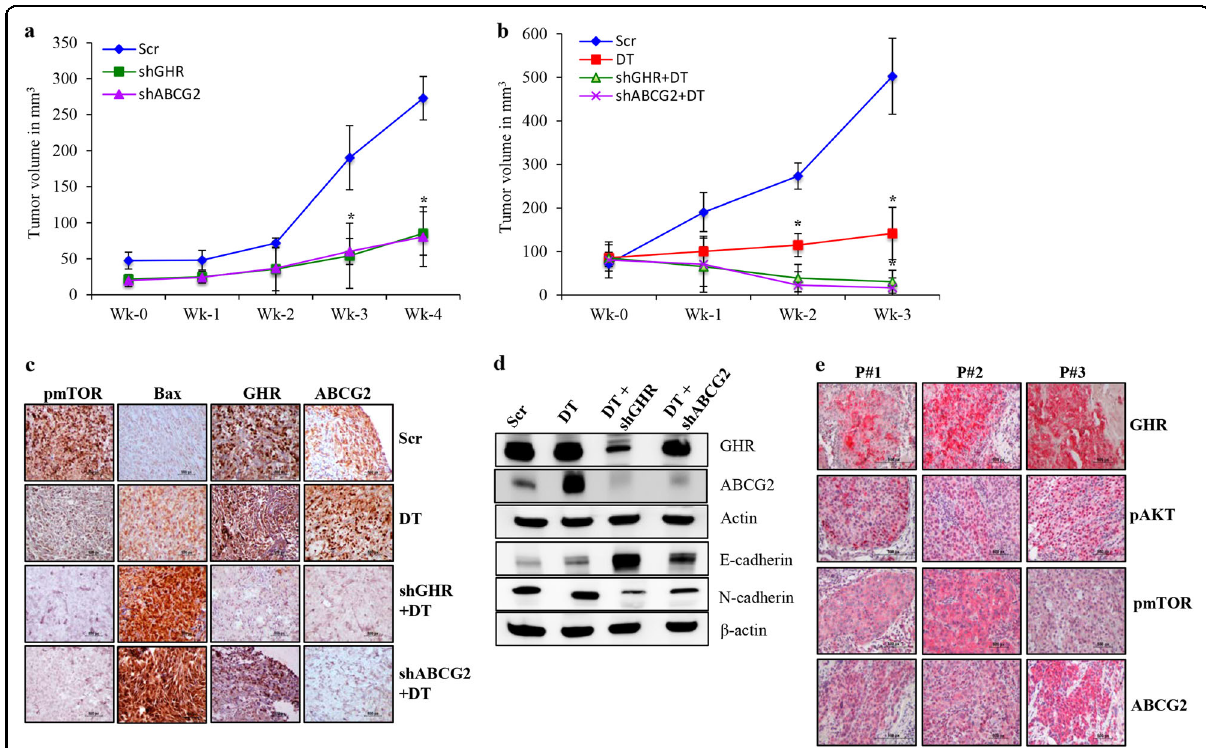
Fig. 6 GHR and ABCG2 knockdown ef fi ciently inhibited the growth of primary breast cancer cells in vivo. a Primary breast cancer cells were stably transfected with scrambled shRNA (Scr & DT groups), GHR shRNA (shGHR group), or ABCG2 shRNA (shABCG2) and ~5 × 10 6 cells resuspended in matrigel were injected into the fl anks of athymic nude mice and the tumor growth was observed. shGHR and shABCG2 tumor growth was very slow compared to control group. b Tumors (~100 mm 3 ) were treated with DT (2.5 mg/kg body weight) and the tumor growth was monitored. GHR and ABCG2 knockdown increased the sensitivity of primary breast cancer cells to DT treatment. DT alone treatment did not reduce the tumor growth, but DT treatment along with GHR or ABCG2 knockdown signi fi cantly reduced the tumor growth ( p < 0.05). c Representative IHC pictures of pmTOR, Bax, GHR, and ABCG2. IHC analysis showed that both shGHR and shABCG2 groups had reduced pmTOR expression and increased Bax expression. d Western blot of xenograft tumors isolated from nude mice showing the expression of GHR and ABCG2. GHR, and ABCG2 levels were reduced in the respective, shRNA transfected groups. e Immunohistochemical staining of GHR, pAKT, pmTOR, and ABCG2 expression in three different primary human breast cancers (P#1 — Patient 1; P#2 — Patient 2; P#3 — Patient 3). Primary breast cancers expressing high levels of GHR also stained strongly for pAKT, pmTOR, and ABCG2, demonstrating the association of GHR with these proteins in primary breast